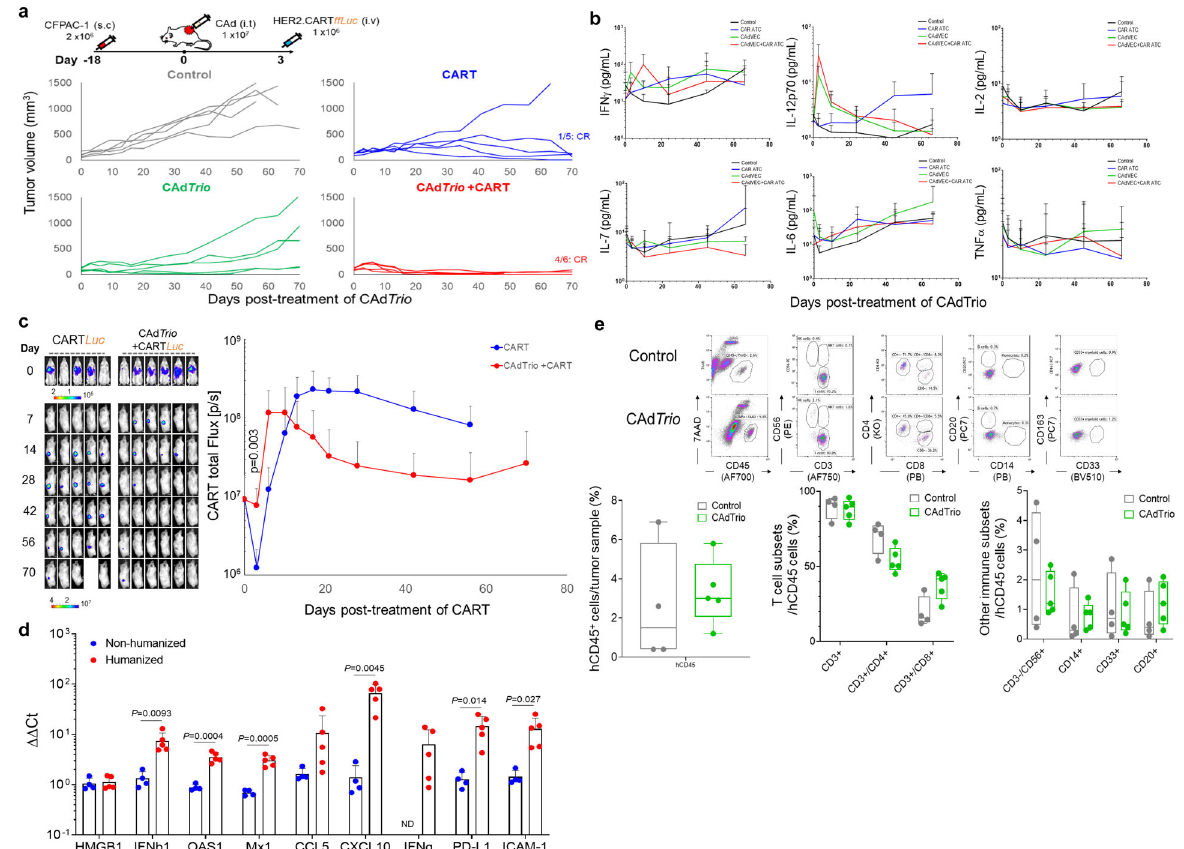
Fig. 4 Combination immunotherapy controls CFPAC-1 tumor growth in humanized mouse model. a CFPAC-1 cells were transplanted into the right fl ank of humanized mice (control, CART alone, CAd Trio alone: n = 5 animals, CAd Trio + CART: n = 6 animals). A total of 1 × 10 7 vp of CAdTrio (OAd:HD = 1:1) were injected into the tumor. A total of 1 × 10 6 HER2.CARTs expressing ffLuc were systemically administered 3 days post injection of CAd Trio . Tumor volumes were monitored at different time points. b We collected serum samples from mice at 0, 3, 10, 24, 45, and 66 days post injection of CAd Trio , and measured human Th1 and Th2 cytokine levels by Multiplex. Data are presented as means ± SD. c Bioluminescence of HER2.CARTs was monitored at different time points. Data are presented as means ± SD, p = 0.003. P -values were determined using two-tailed t test ( t ratio = 4.213, dF = 8). d CFPAC-1 tumors were harvested from non-humanized and humanized mice (non-humanized mice: n = 4 animals, humanized mice: n = 5 animals) at 3 days post injection of CAd Trio , and total RNA was extracted from whole tumors. Pro-in fl ammatory genes were quanti fi ed and normalized with human β -Actin. Data are presented as means ± SD. P -values were determined using two-tailed t test; p = 0.0093 ( t ratio = 3.553, dF = 7), p = 0.0004 ( t ratio = 6.352, dF = 7), p = 0.0005 ( t ratio = 6.084, dF = 7), p = 0.0045 ( t ratio = 4.101, dF = 7), p = 0.014 ( t ratio = 3.226, dF = 7), p = 0.027 ( t ratio = 2.782, dF = 7). Statistical signi fi cance set at p < 0.05, ns > 0.05. e CFPAC-1 tumors were harvested from humanized mice (non-humanized mice: n = 4 animals, humanized mice: n = 5 animals) at 3 days post injection of CAd Trio , and tumor in fi ltrating human immune cells were analyzed with fl ow cytometry. Box plot elements: central line, median; box limit, upper and lower quartiles; whisker, 1.5x inter-quartile range; points, outliers. Abbreviations: s.c. subcutaneous, i.t. intratumoral, i.v. intravenous, ND not